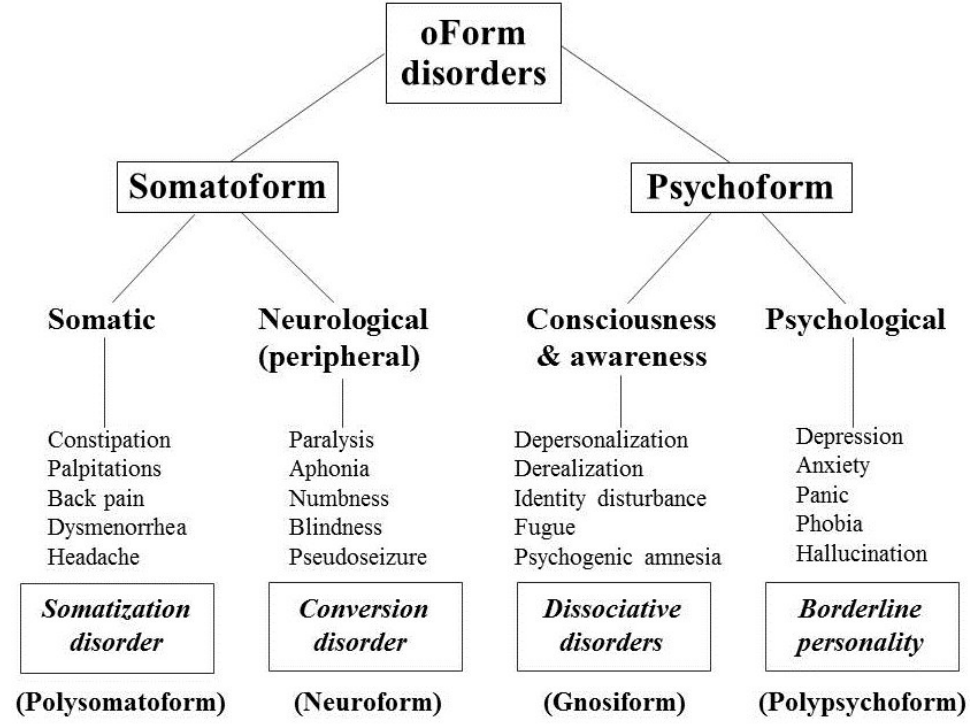
Figure 1. Schematic conceptualization of psychiatric disorders historically classified as hysteria and phenomenologically related